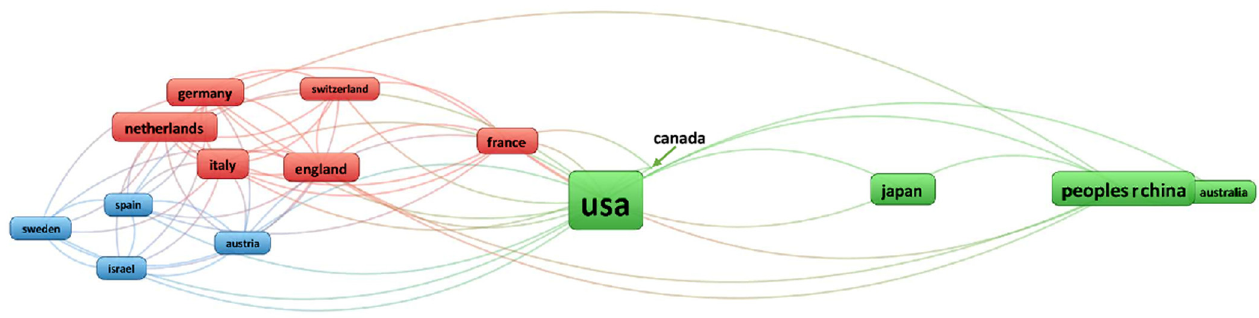
Figure 2. International collaboration network among countries publishing on ARM between 1970 and 2020.